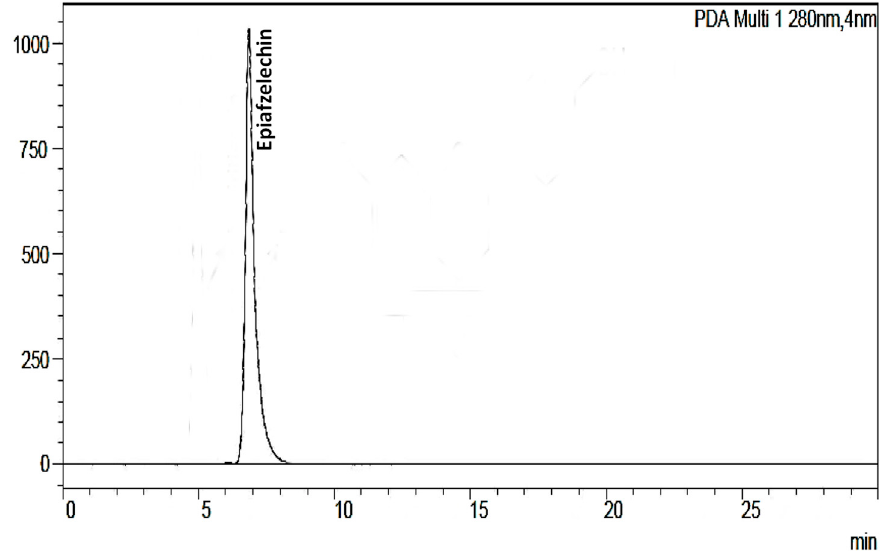
Figure 7. The HPLC (High-Performance Liquid Chromatography) chromatogram of Epiafzelechin (CFL1 fraction) isolated from C. fistula leaves.